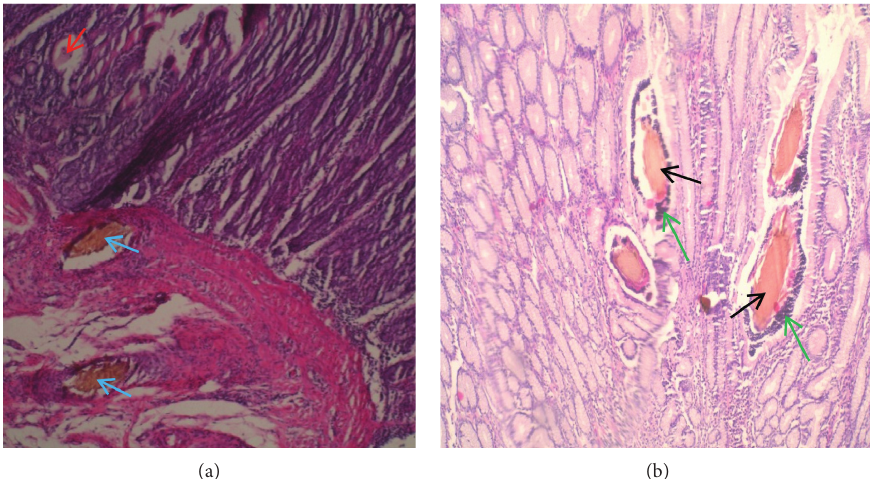
Figure 13: (a) Several Opuntia stricta thorns penetrating deep into the glandular mucosa (red arrow) and tunica muscularis (blue arrows) of the abomasum in mild abomasitis (x40). (b) Opuntia stricta thorns in the glandular mucosa of abomasum (black arrows) causing pressure atrophy of glands and attracting mononuclear cells infiltrations around them in mild case of abomasitis (green arrows) (x100).